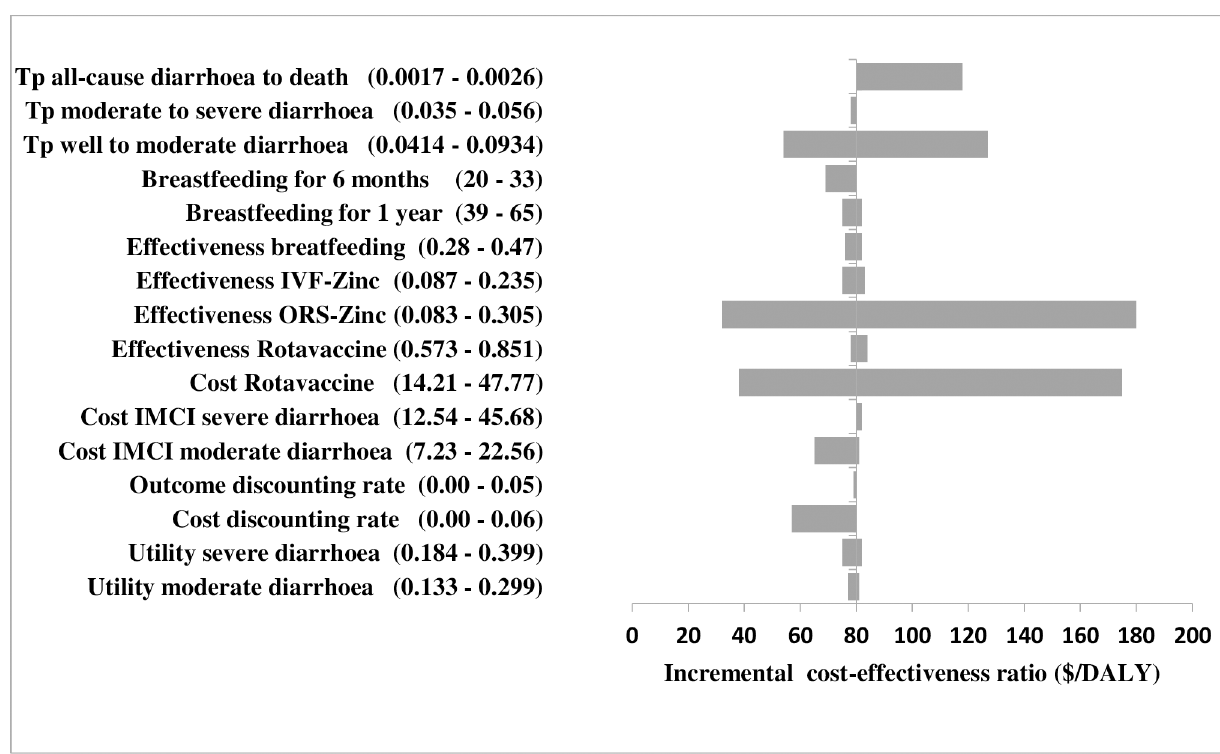
Fig 2. Tornado diagram showing the uncertainty impact of key parameters on the ICER result of the most cost-effective approach. Tp: Transition ProbabilityLeft: Higher limit ICER values Right: Lower limit ICER values.